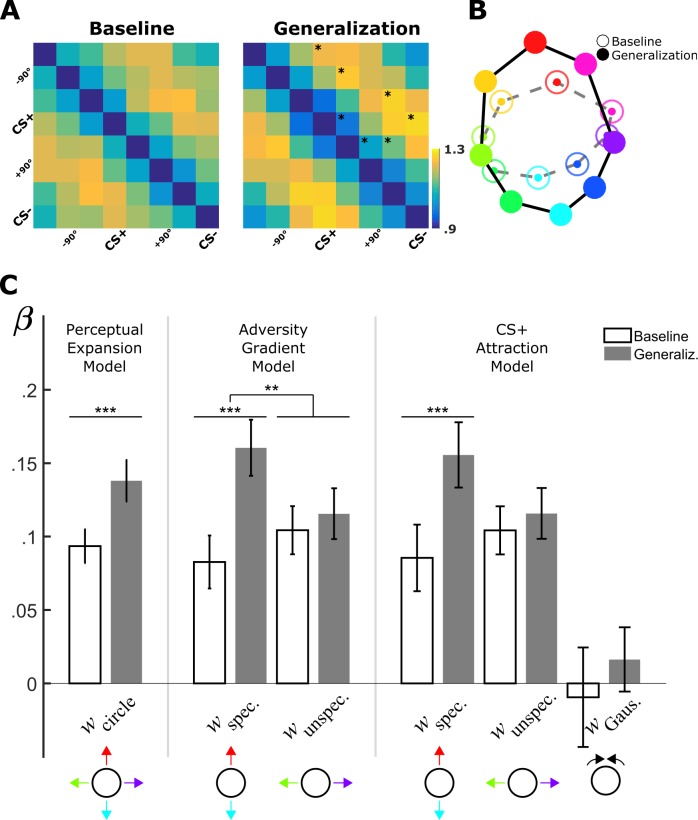
Fixation-pattern similarity analysis.(A) Dissimilarity matrices of exploration patterns for baseline (left panel) and generalization phases (right panel). Fourth and eight columns (and rows) are aligned with each volunteer’s CS+ and CS– faces, respectively. Asterisks on the upper diagonal denote significant differences from the corresponding element in baseline. (B) Two-dimensional multidimensional scaling method used for visualization of the 16 × 16 dissimilarity matrix (not shown) comprising baseline and generalization phases. Distances between nodes are proportional to the dissimilarity between corresponding FDMs (open circles: baseline; filled circles: generalization phase; same color scheme as in Figure 1). (C) Bar plots (M ± SEM) depict predictor weights estimated for single-participants before (white bars) and after (gray bars) aversive learning (Left: Perceptual Expansion Model; Middle: Adversity Gradient Model; Right: CS+ Attraction Model). wcircle: weight for the circular component, which is the sum of equally weighted specific and unspecific components; wspecific/wunspecific: weights for specific and unspecific components; wGauss: weight for Gaussian component centered uniquely on the CS+. (**: p<0.01; ***: p<0.001, paired t-test).